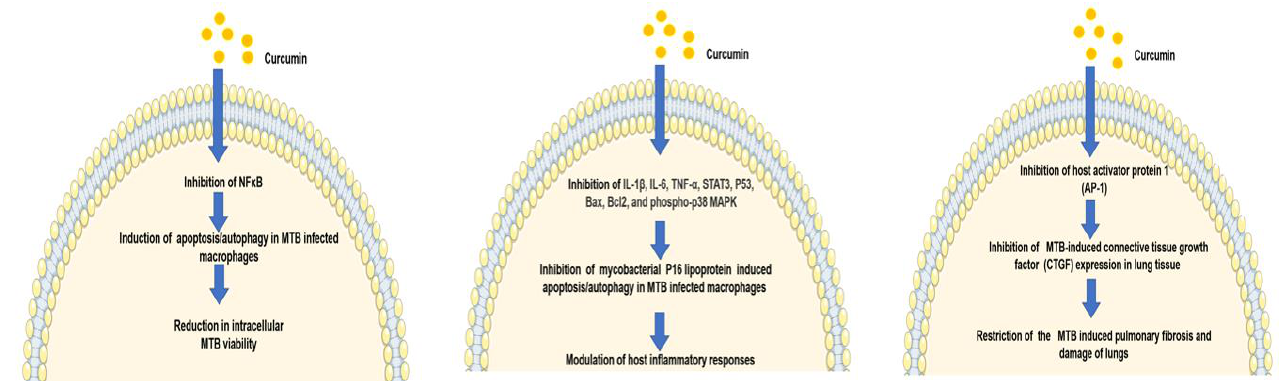
Figure 3. Various mechanisms of curcumin antitubercular activity via modulation of the host immune response. The figure was produced using Servier Medical Art (http://smart.servier.com/ accessed on 1 February